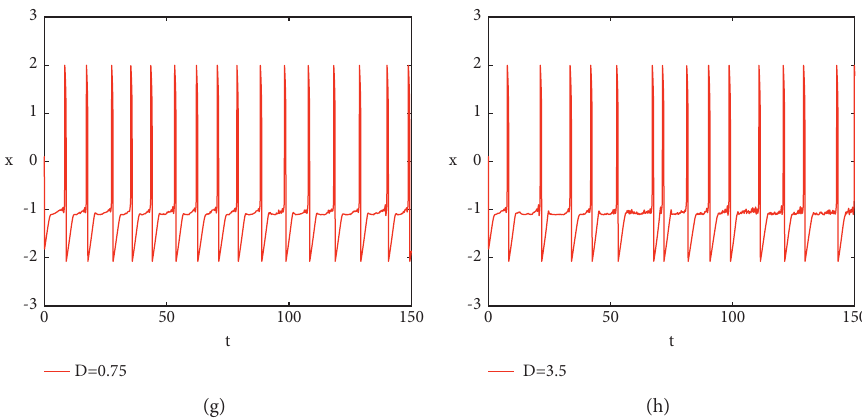
Figure 12: When the period of phase noise varies, the variation of coherence resonance coefficient R with the phase noise intensity D and the time evolution diagram of the system membrane potential x . (a)When T � 3 . 5, variation of R with; (b) T � 3 . 5, D � 0 . 4; (c) T � 3 . 5, D � 1 . 7; (d) T � 3 . 5, D � 3; (e) When T � 9 . 5,variation of R with D ; (f) T � 9 . 5, D � 0; (g) T � 9 . 5, D � 0 . 75; (h) T � 9 . 5, D � 3 .